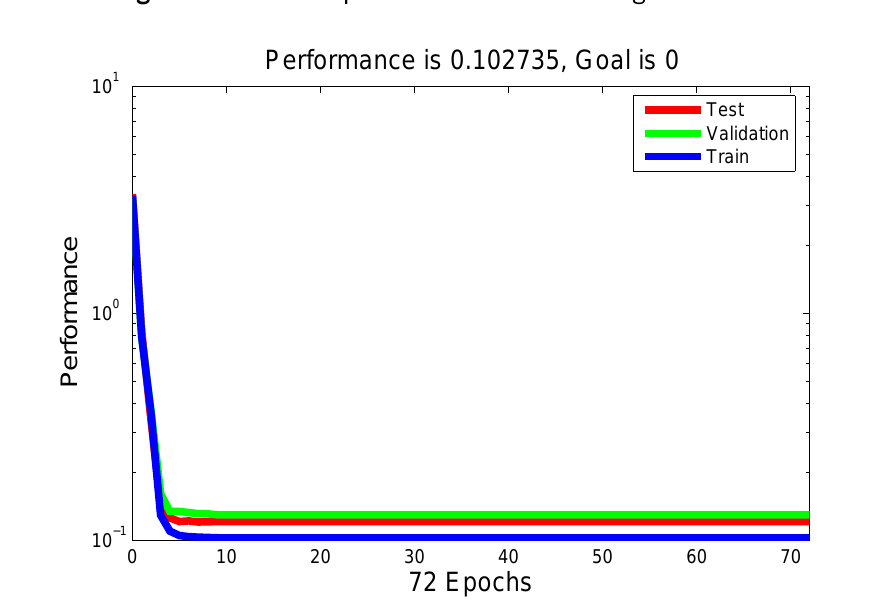
Figure 13. An independent test of network